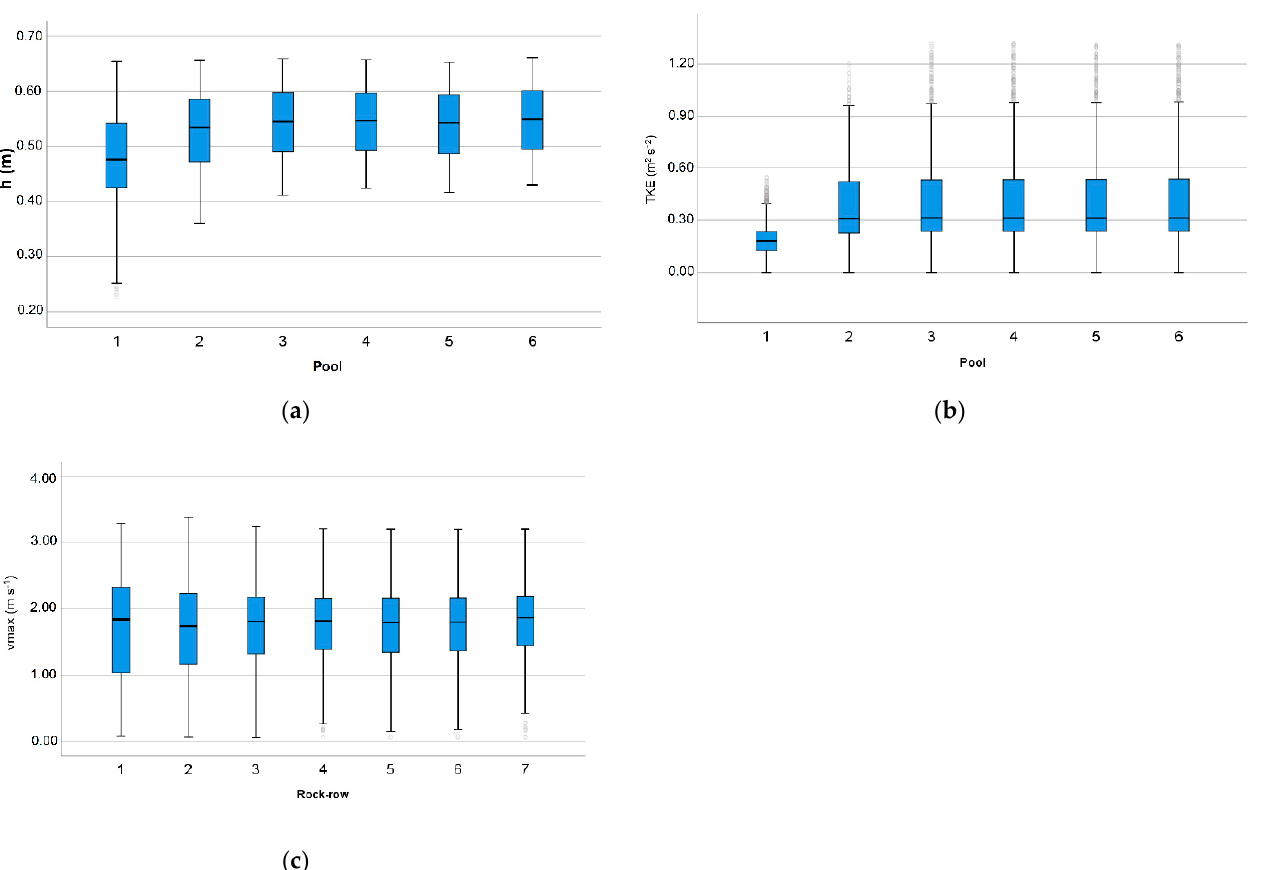
Table 3. p -values from Kruskal-Wallis test when uphill velocities from the different corridors are compared.